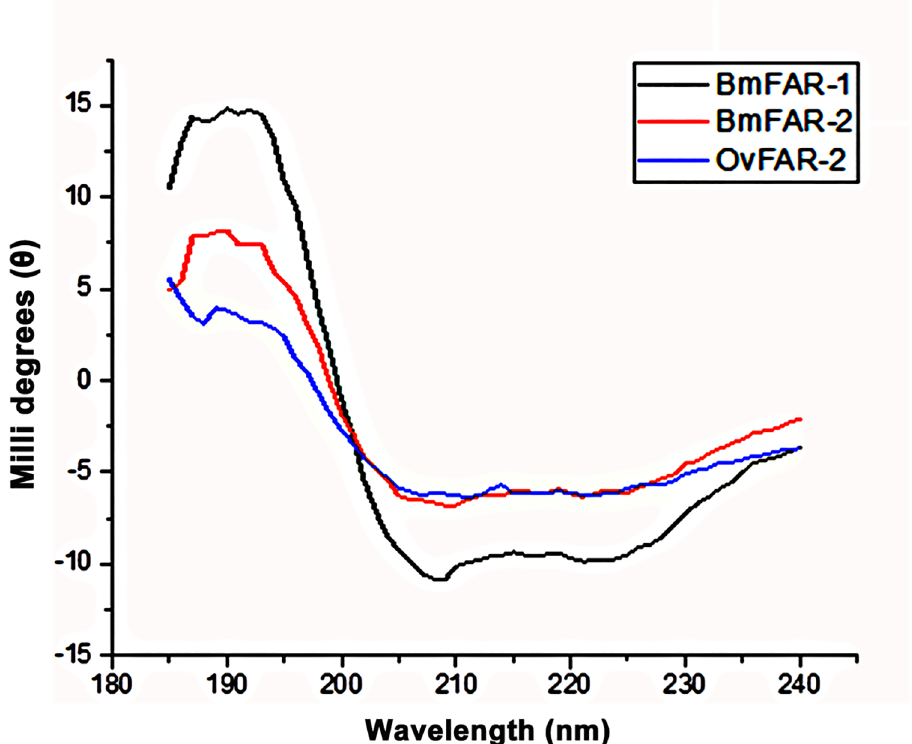
Fig 4. Circular dichroism spectra of r Bm- FAR-1, r Bm- FAR-2 and r Ov -FAR-2 in 20 mM Tris, 20 mM NaCl, pH 6.8 TBS, 25 o C.